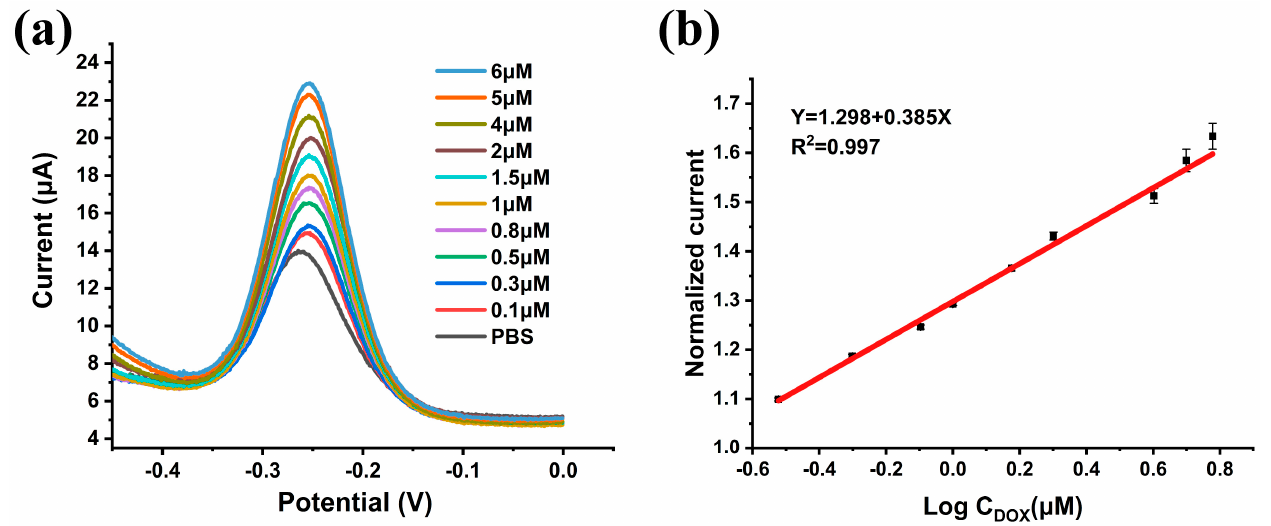
Figure 4. ( a ) SWV responses of the aptasensor to different concentrations of DOX standard solutions (0.1 µM to 6 µM) in 0.1 M PBS solution; ( b ) calibration curve of the aptasensor between DOX concentration and normalized SWV peak current.